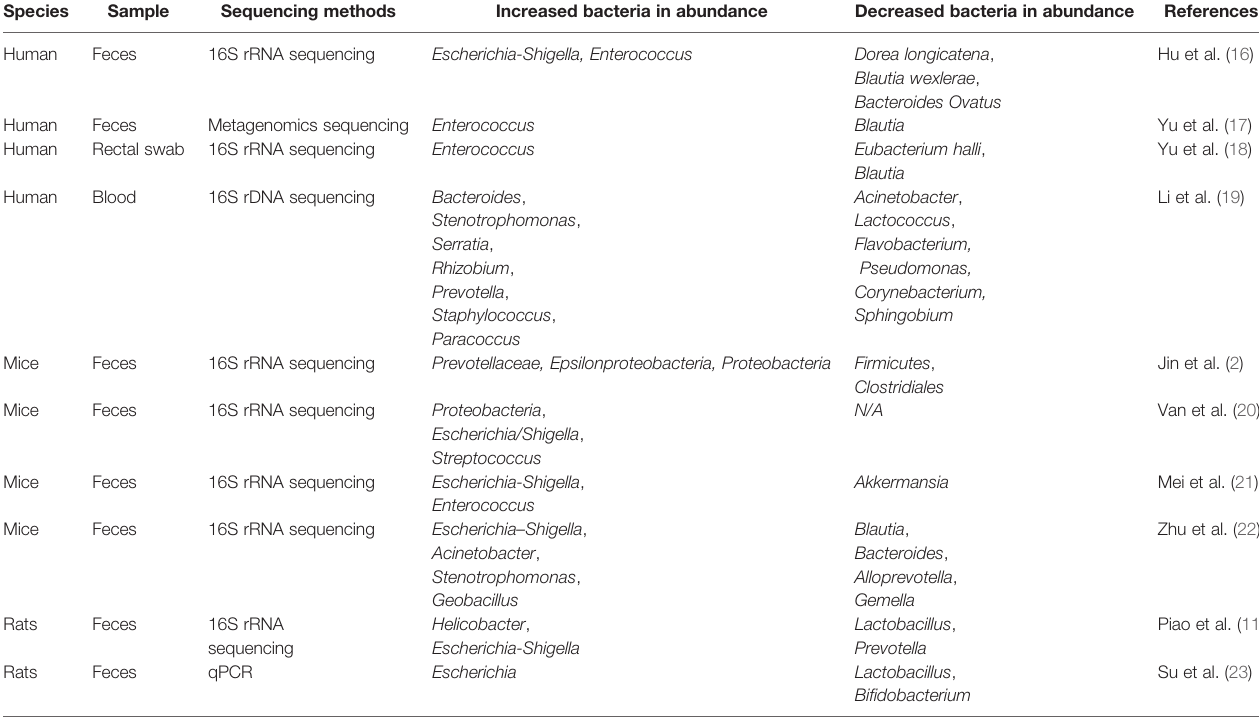
TABLE 1 | Intestinal microbiota dysbiosis in